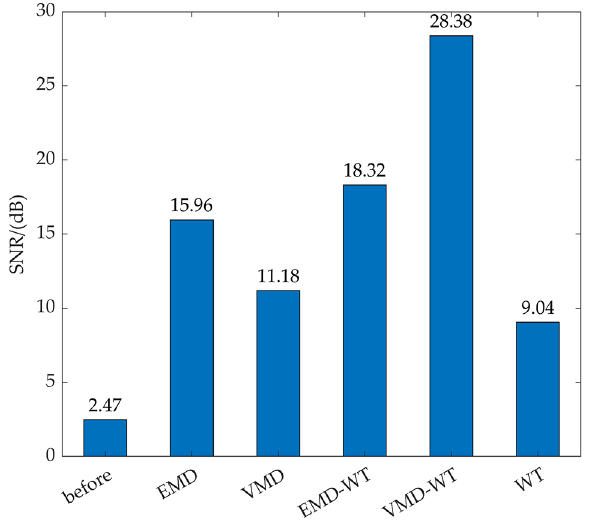
Figure 9. SNR of the tea dynamic weighing signal with different denoising methods.